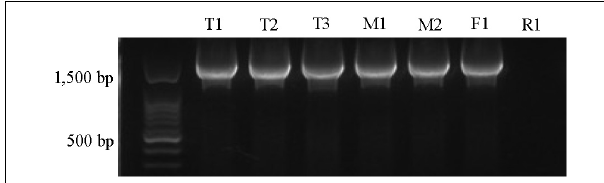
FIGURE 2 | Amplification of tetC and tetR (1.9 kb amplicon) in oxytetracycline-resistant Xanthomonas arboricola pv. pruni strains. The primers tetR-Xbal/tetR-kpn1 were used. The strain IDs were labeled on top of the gel picture. The 100 bp ladder (Biotium, Fremont, CA, United States) was used. All of these strains tested positive for Xap using the probe-based qPCR assay (Palacio-Bielsa et al., 2011).